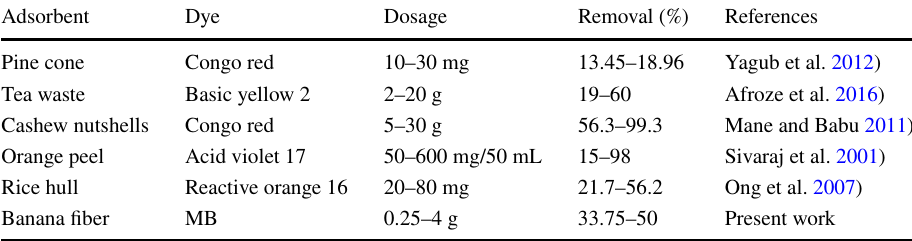
Table 3 Comparison of the performance of PBF with different low-cost adsorbents regarding various adsorbent